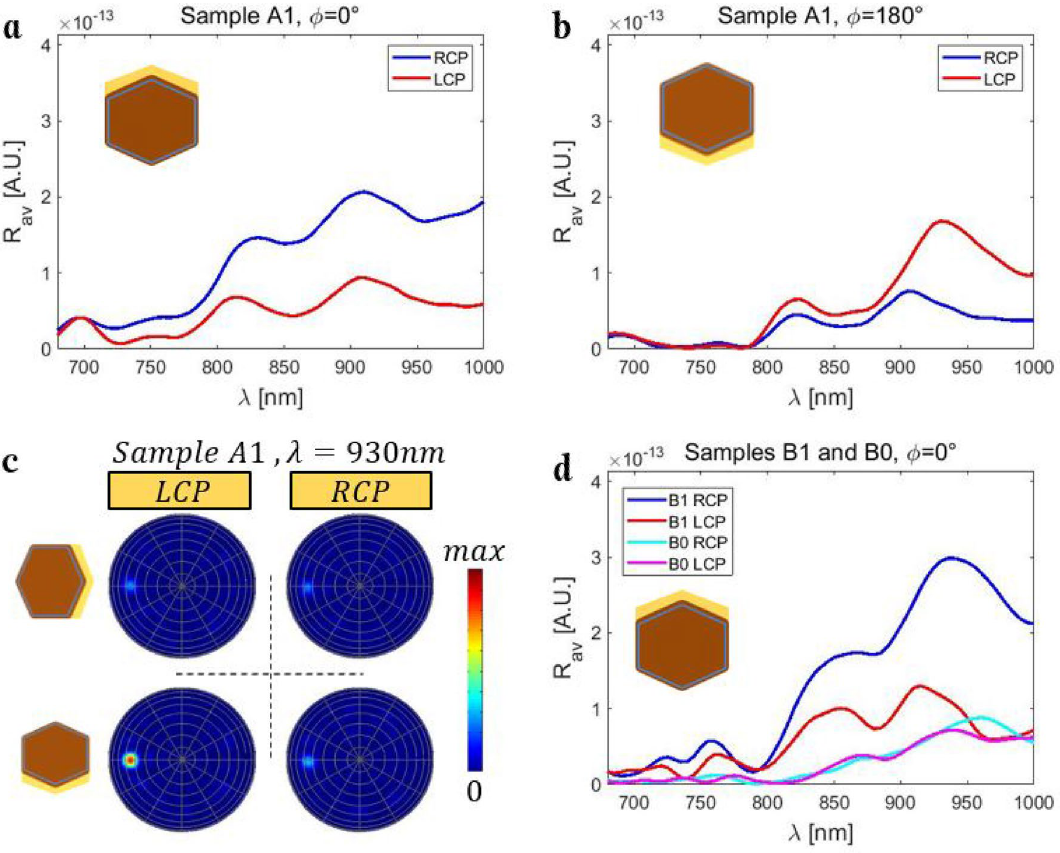
Figure 6. RCP and LCP far-field reflection spectra for orientations of Sample A1: ( a ) Far-field for LCP and RCP excitations at 930 nm, for Sample A1 at and LCP far-field reflection spectra for Samples B1 and B0, at